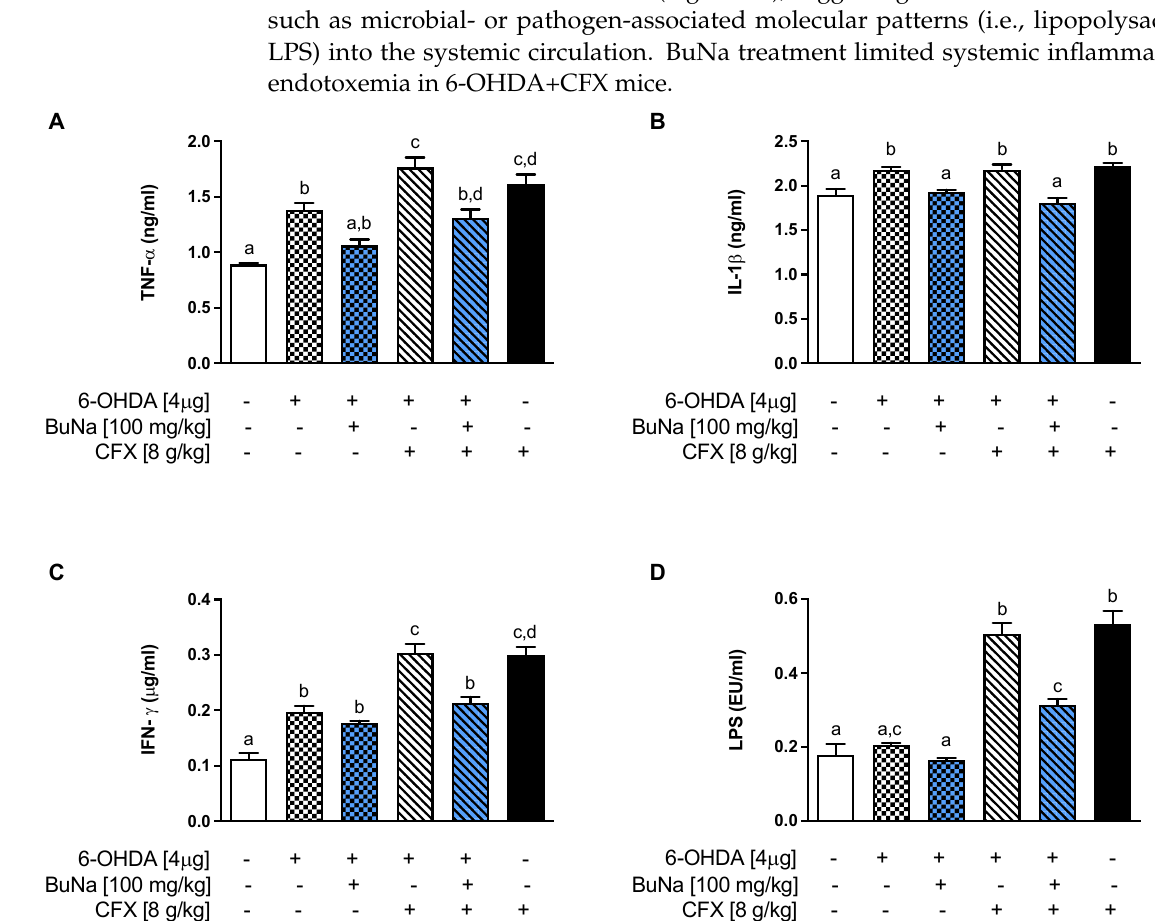
Figure 3. BuNa-modulated systemic parameters of the immune system and inflammation altered by 6-OHDA and CFX. BuNa-limited ( A ) TNF-α, ( B ) IL-1β, ( C ) IFN-γ, and ( D ) LPS increased in 6-OHDA and/or CFX+6-OHDA mice. All data are shown as mean ± S.E.M ( n = 6 per group). Labeled means without a common letter differ, p < 0.05.